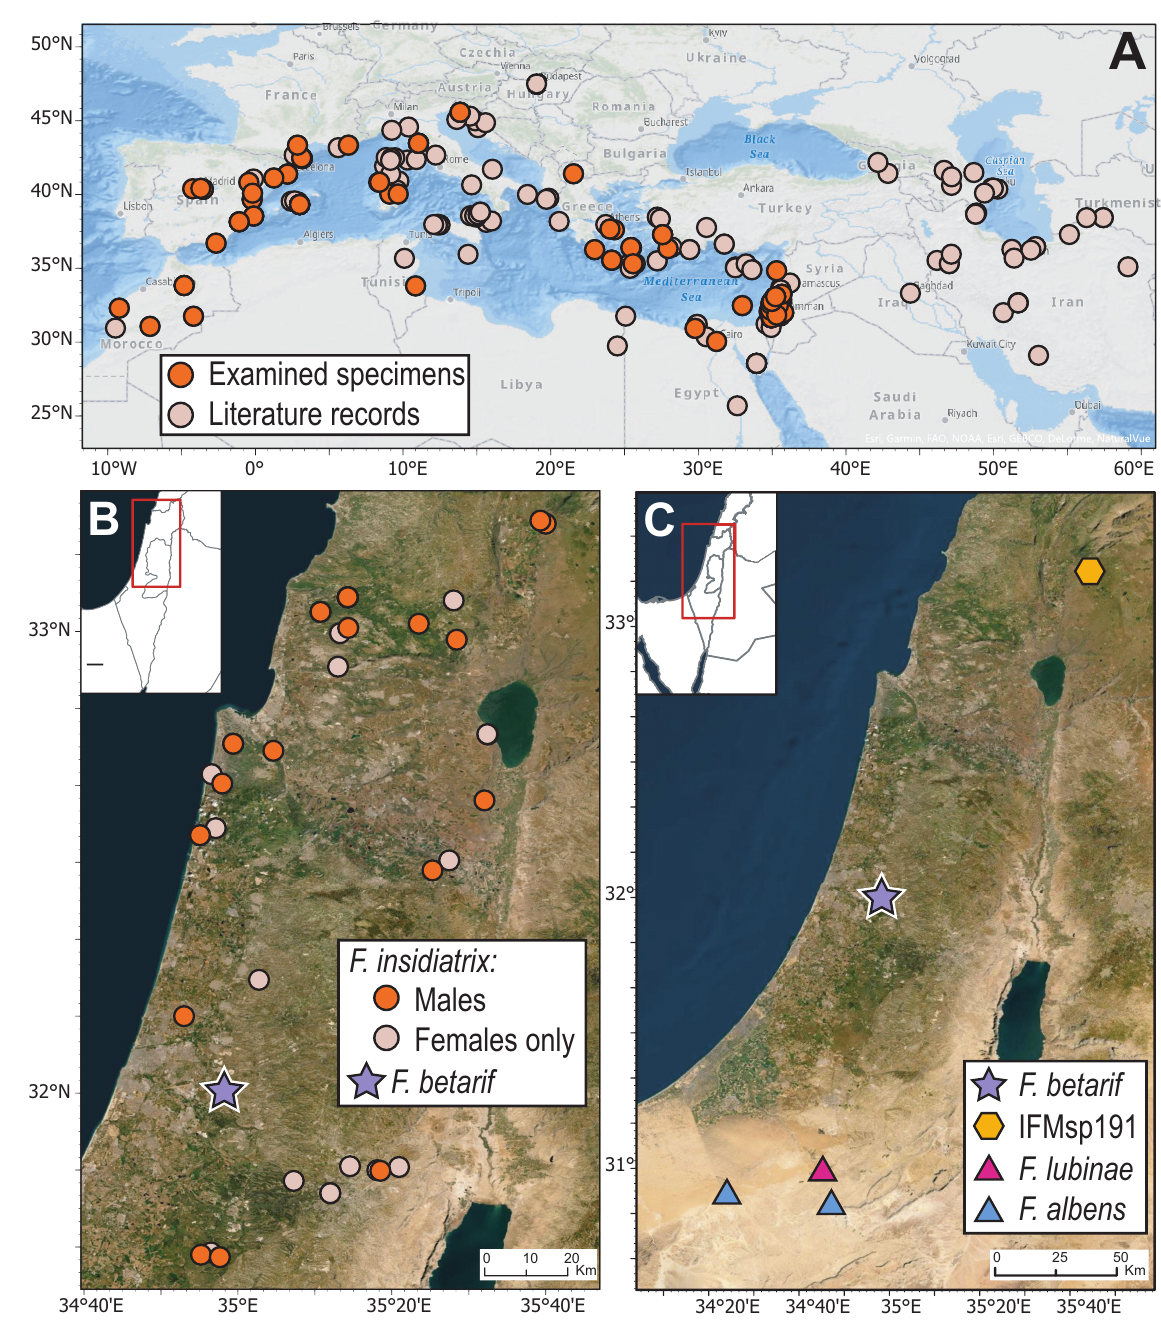
Fig. 4. Distribution maps. A . Filistata insidiatrix (Forsskål, 1775) in the Mediterranean and Middle East (note the species has been recorded from Angola, Venezuela and the islands of Socotra, Azores and Cabo Verde, but these records seem to be introduced); literature records have been taken from Benoit (1968), Brignoli (1982), Marusik & Zonstein (2014), Marusik & Zamani (2015a) and Zonstein & Marusik (2019). B . Filistata insidiatrix (circles) and F. betarif sp. nov. (star) in Israel and Palestine; only specimens examined by us are included in the map. Darker shades of orange are records that include at least one male specimen. C . Other species of Filistata Latreille, 1810 in Israel (except F. insidiatrix